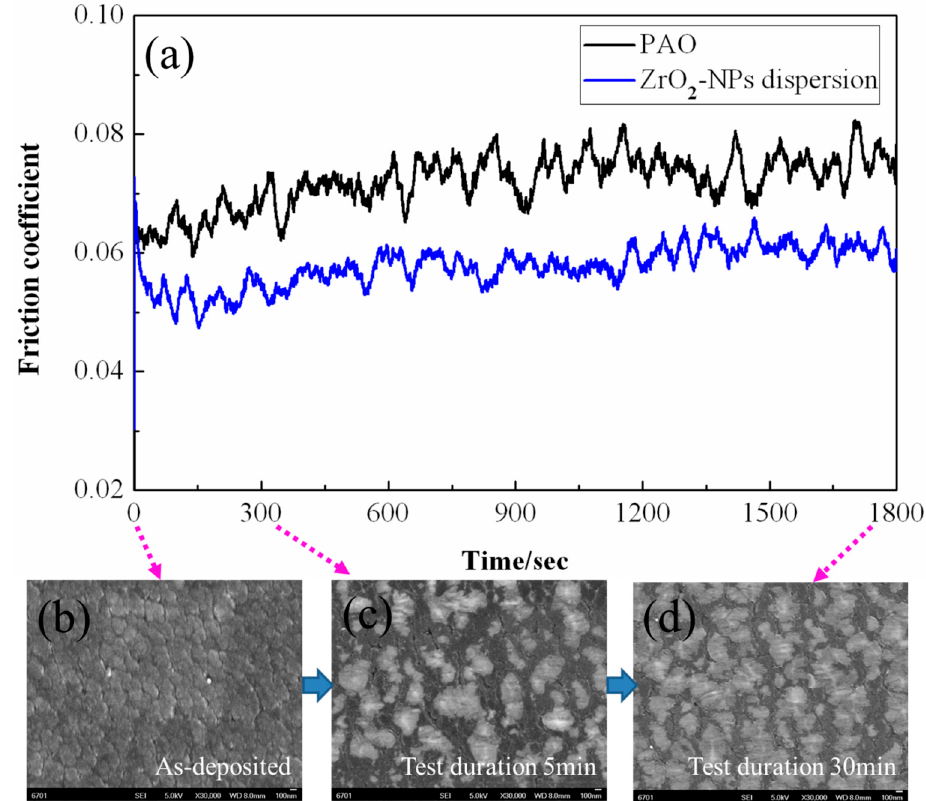
Figure 12. ( a ) The variation of COF of a-C contacts with respect to sliding time. The FESEM images of: ( b ) the as-deposited a-C surface; and the worn a-C surface under the lubrication of ZrO 2 -NPs dispersion for: ( c ) 5 min; and ( d ) 30 min.